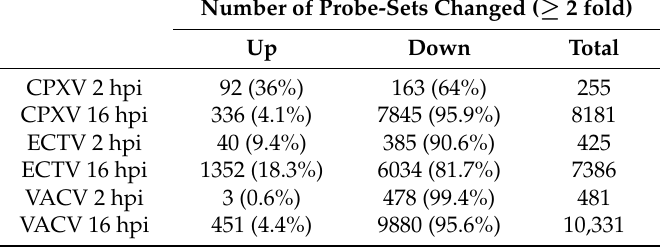
Table 1. Summary of the probe-sets showing up-regulated and down-regulated gene expression. At 2 and 16 h post infection, RAW cells were infected with cowpox virus (CPXV), vaccinia virus (VACV), and ectromelia virus